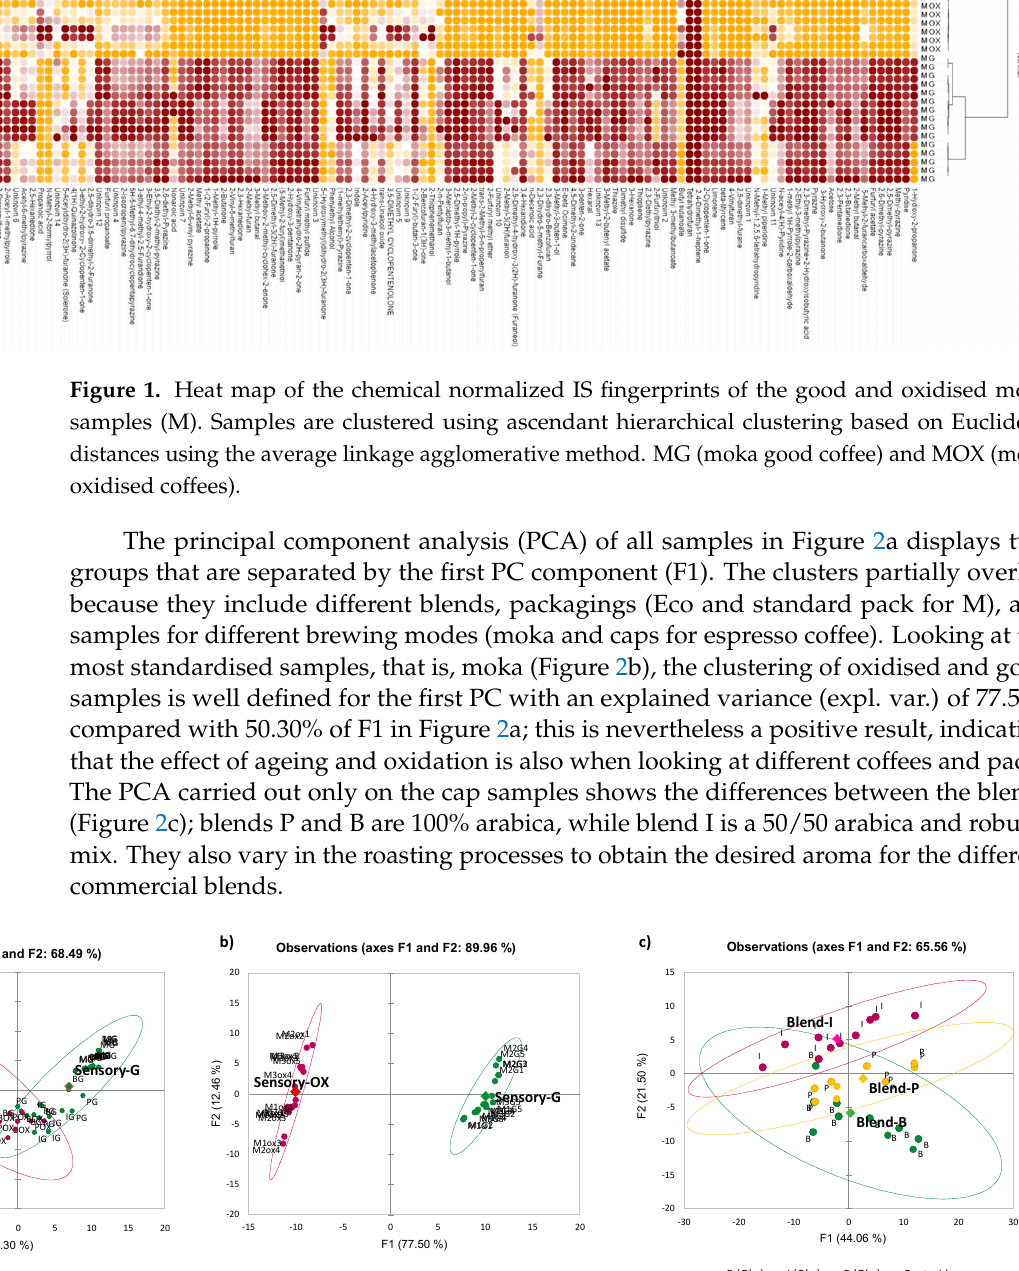
Figure 2. PCA of all samples investigated: ( a ) good and oxidised samples, 2, ( b ) moka good and oxidised samples, ( c ) blends in Eco-caps.